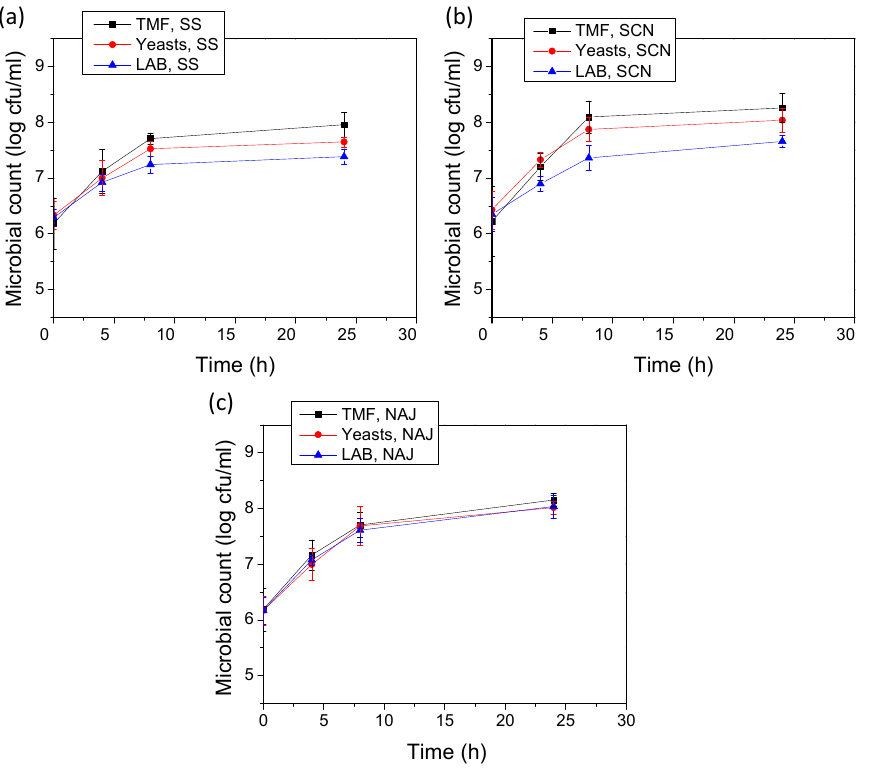
Figure 8. Microbial counts for total mesophilic flora (TMF) and yeasts and lactic acid bacteria (LAB), during the 24 h fermentation of fermentation of Sucrose solution, SS (a); sour cherry nectar, SCN (b) and natural apple juice, NAJ (c).